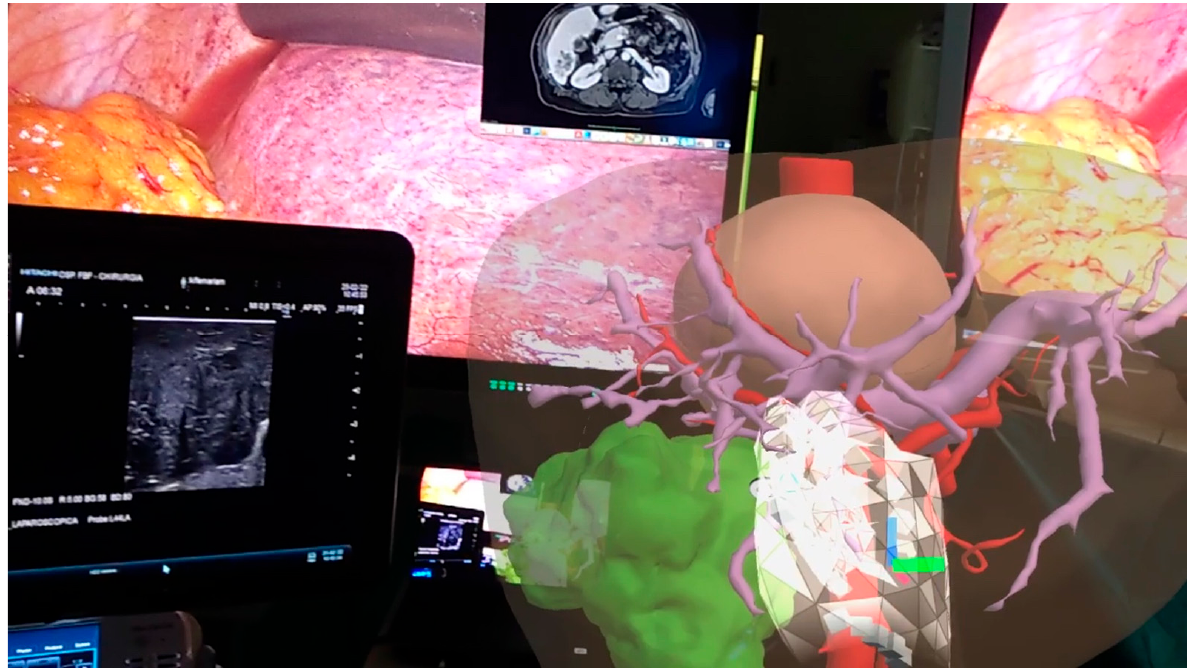
Figure 4. Augmented reality in operating room: surgeon can manipulate the model comparing its features with laparoscopic ultrasound images.